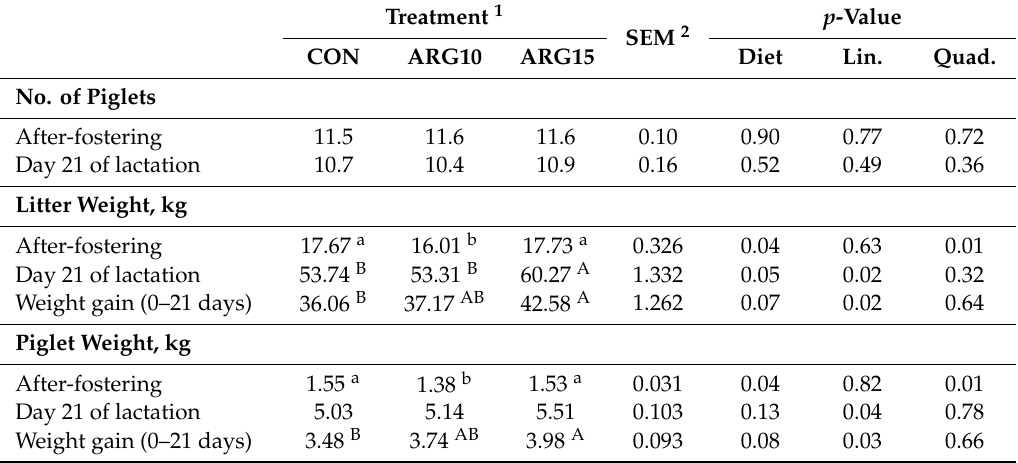
Table 4. E ff ects of arginine supplementation levels on litter performance in late-gestating